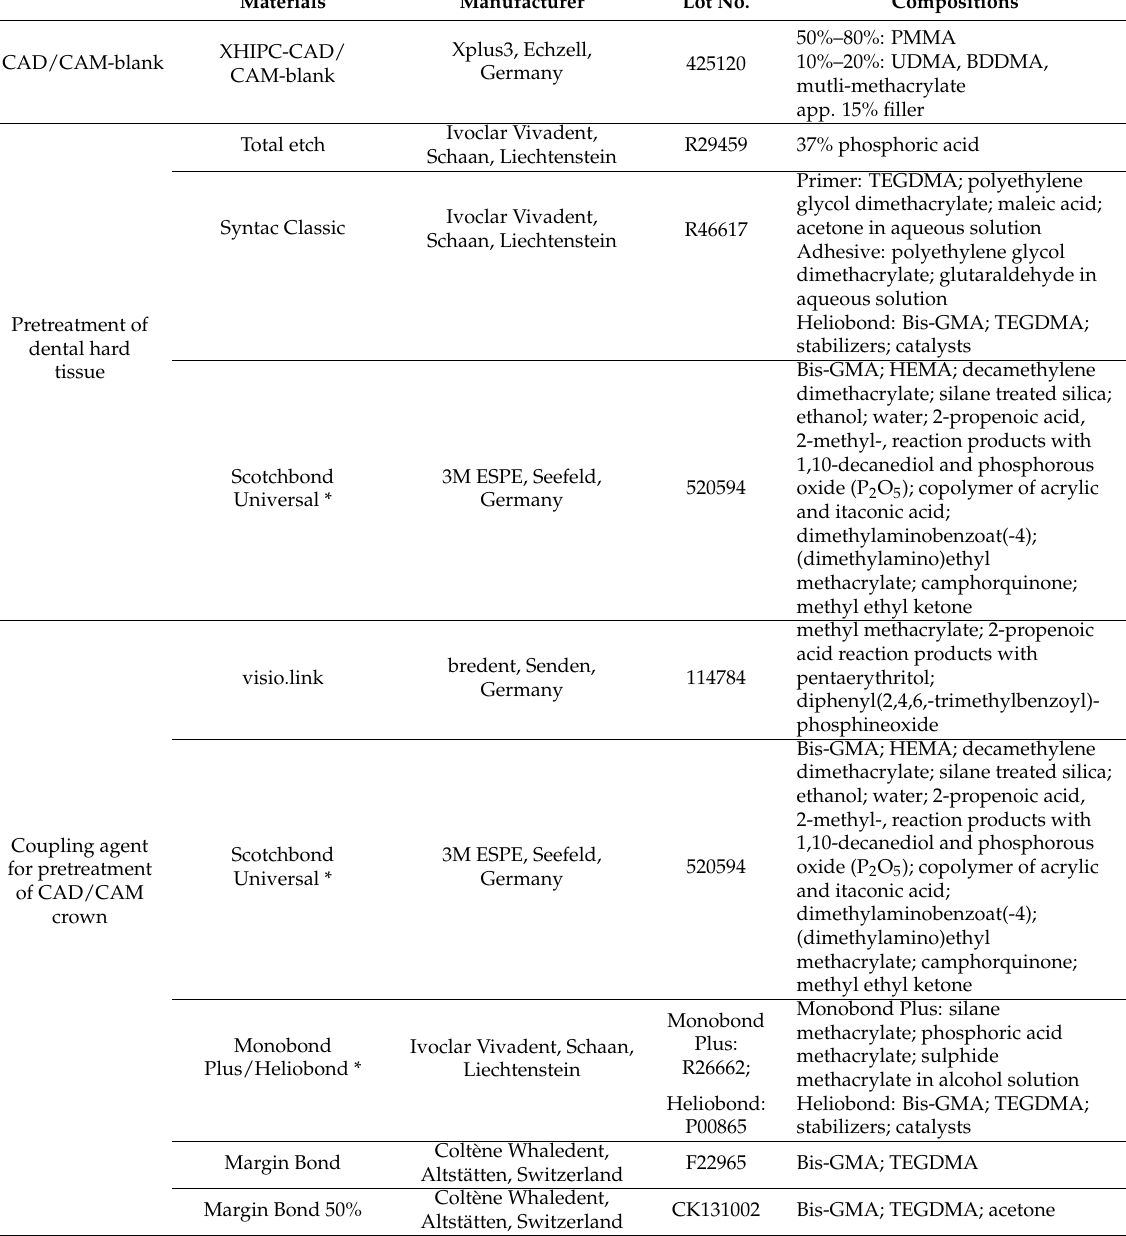
Table 1. Materials, composition and form of application used in the